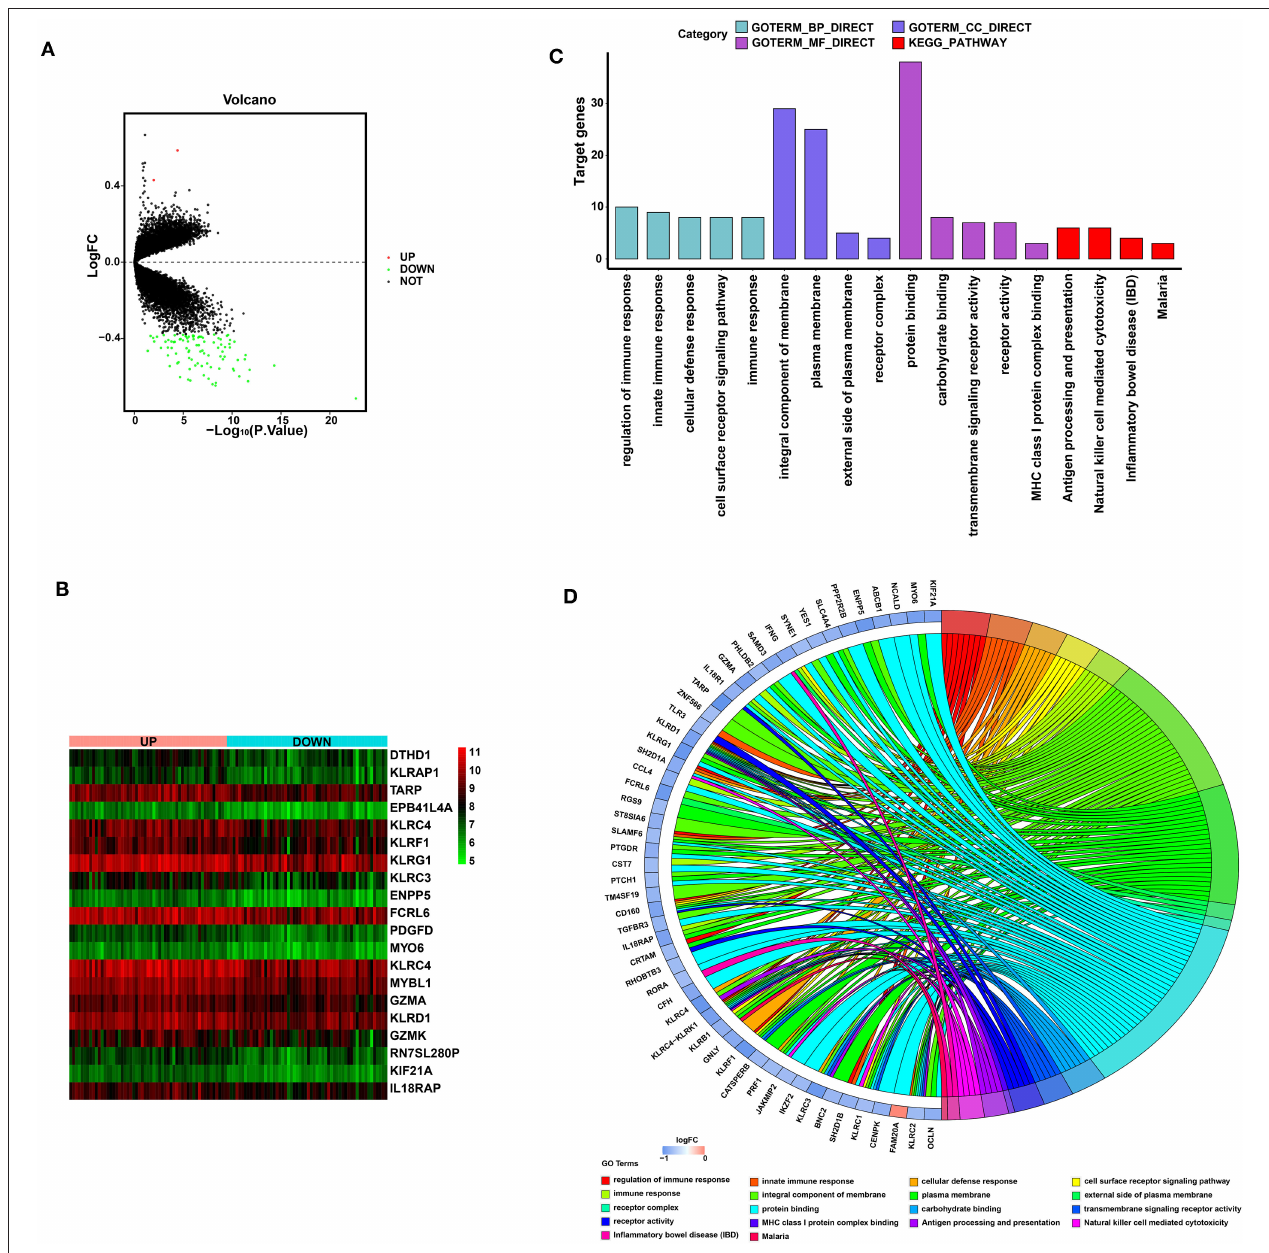
FIGURE 9 | Significant pathways influenced by SYTL2 in the GSE59867 dataset. (A) Volcano plot of the GSE59867 dataset. A total of two upregulated DEGs and 91 downregulated DEGs were identified between low- and high-SYTL2 expression samples. (B) Heatmap of DEGs between low- and high-SYTL2 expression samples in the GSE59867 dataset. (C) DEGs with the top 15 enriched GO terms and KEGG terms. (D) Distribution of DEGs for different GO-enriched functions.